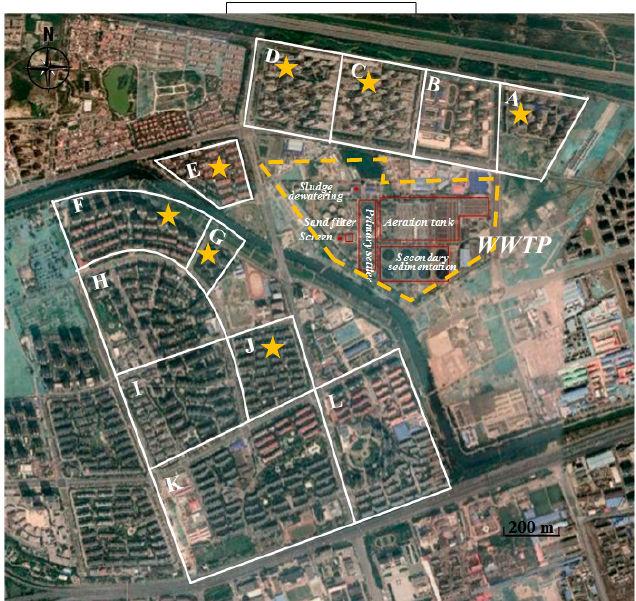
Figure 1. The location of the wastewater treatment plant (WWTP) and twelve surrounding residential areas ( A – L ). The yellow stars which located in seven residential areas ( A ), ( C – G ), and ( J ) represent the major off-site locations of odor complaints. The distance between the boundary of plant and the southwest corner of residential area K is about 1.2 km. WWTP: Municipal wastewater treatment plant.